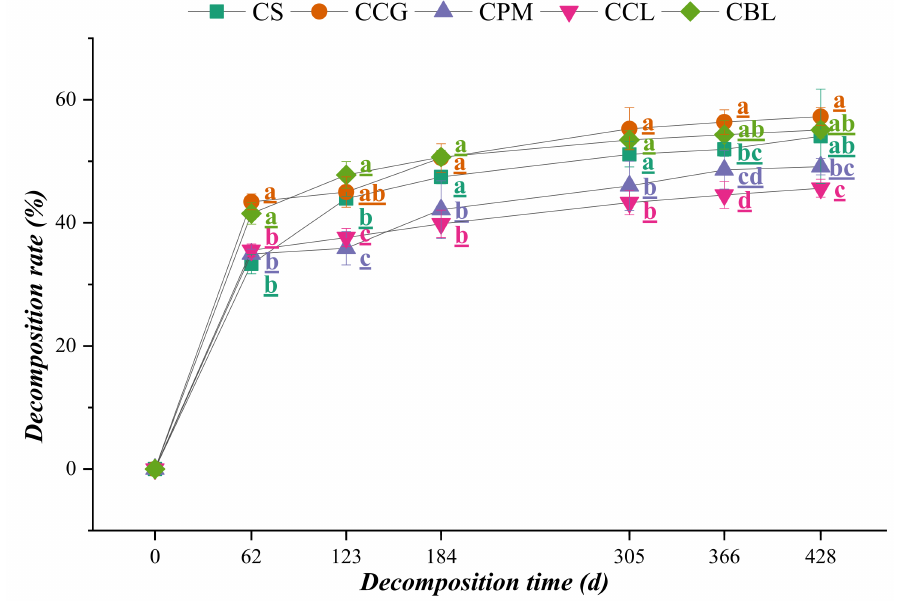
Figure 3. Characteristics of the decomposition rates of the plant residues. Note:. a, b, c—differences between treatments in the same decomposition period. ( p <